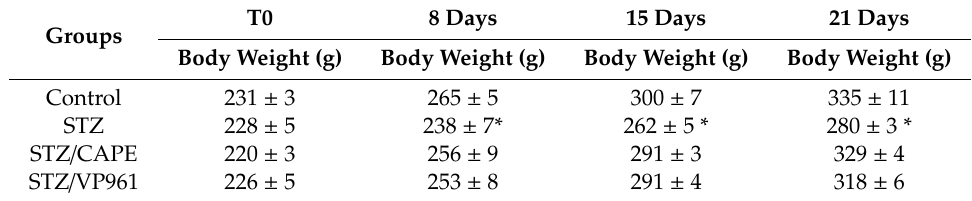
Table 1. Effects of CAPE and VP961 on body weight during the experimental period. Table 1. E ff ects of CAPE and VP961 on body weight during the experimental period. Groups Groups